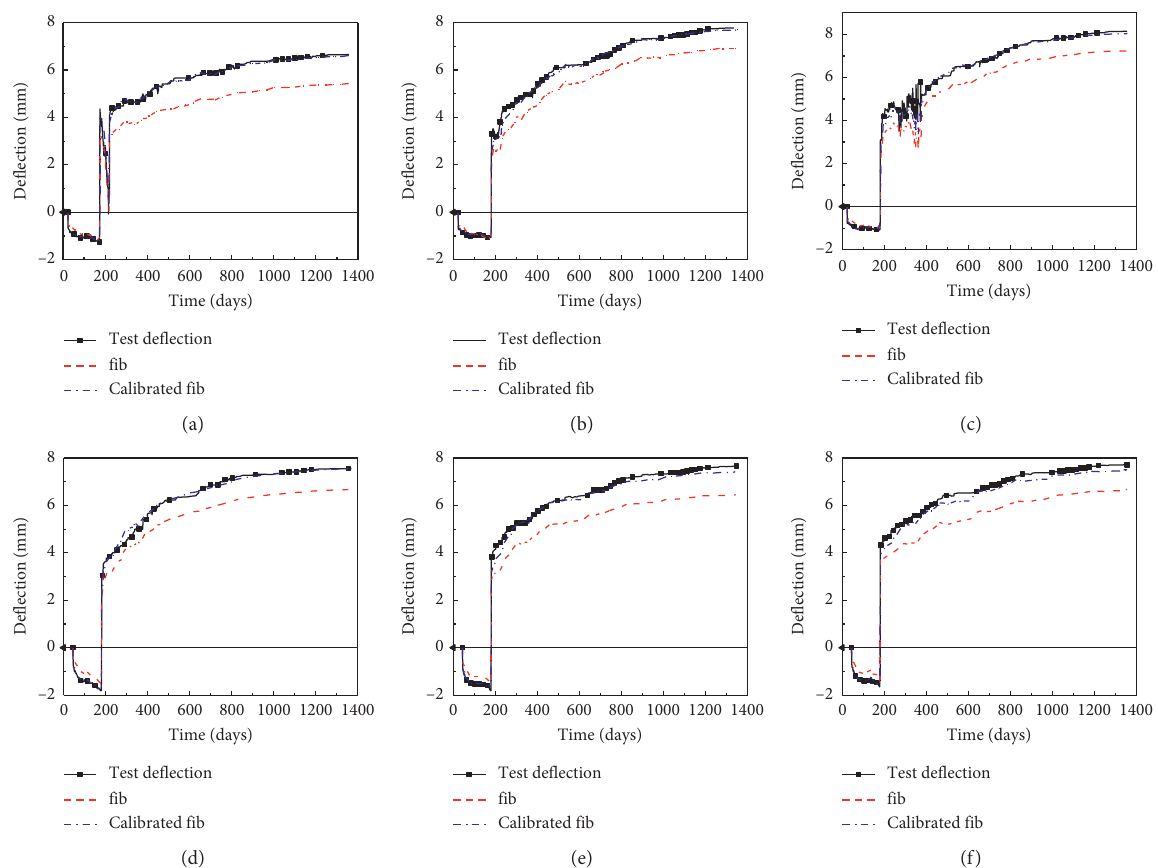
Figure 13: Comparison between the predicted deflection and the test deflection at the midspan of the test beams: (a) PC1; (b) PC2; (c) PC3; (d) PC4; (e) PC5; (f)